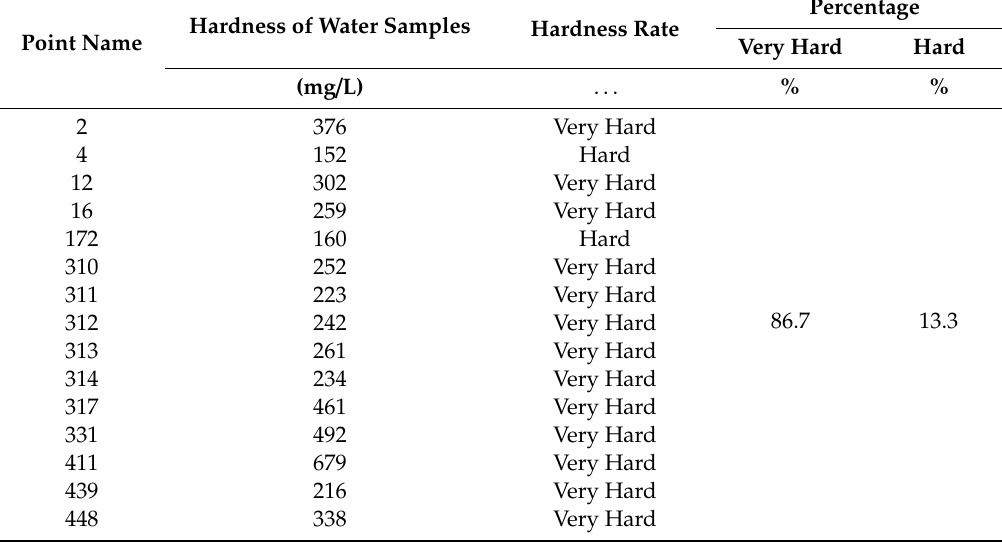
Total hardness of sampled water, the percentage, and groundwater type based on hardness